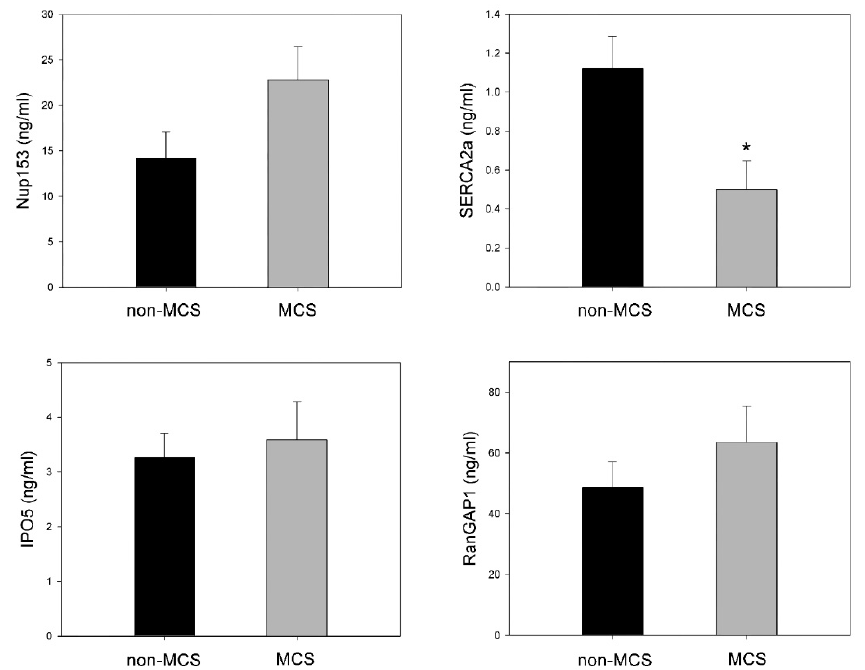
Figure 1. Comparison of the levels of Nup153, SERCA2a, IPO5 and RanGAP1 between patients with (MCS) and without mechanical circulatory support (non-MCS). The values in the graph represent the mean ± SEM (standard error of the mean) with (*) representing statistically significant differences between the two groups ( p = 0.01). All values are in ng/mL.